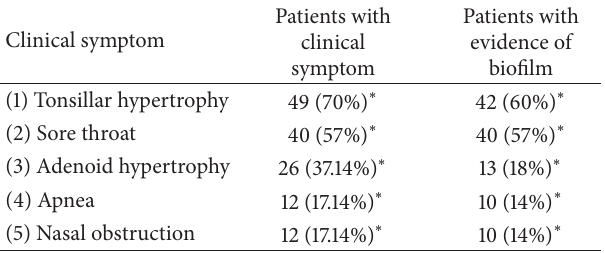
Table 1: Association between the clinical symptoms of tonsillar diseases and the presence of biofilms in